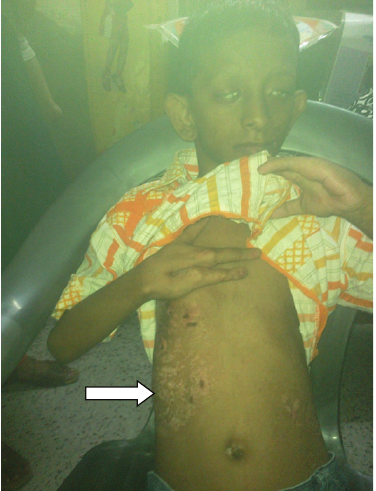
Figure 1: Hypopigmented streaks that follow Blaschko’s lines.